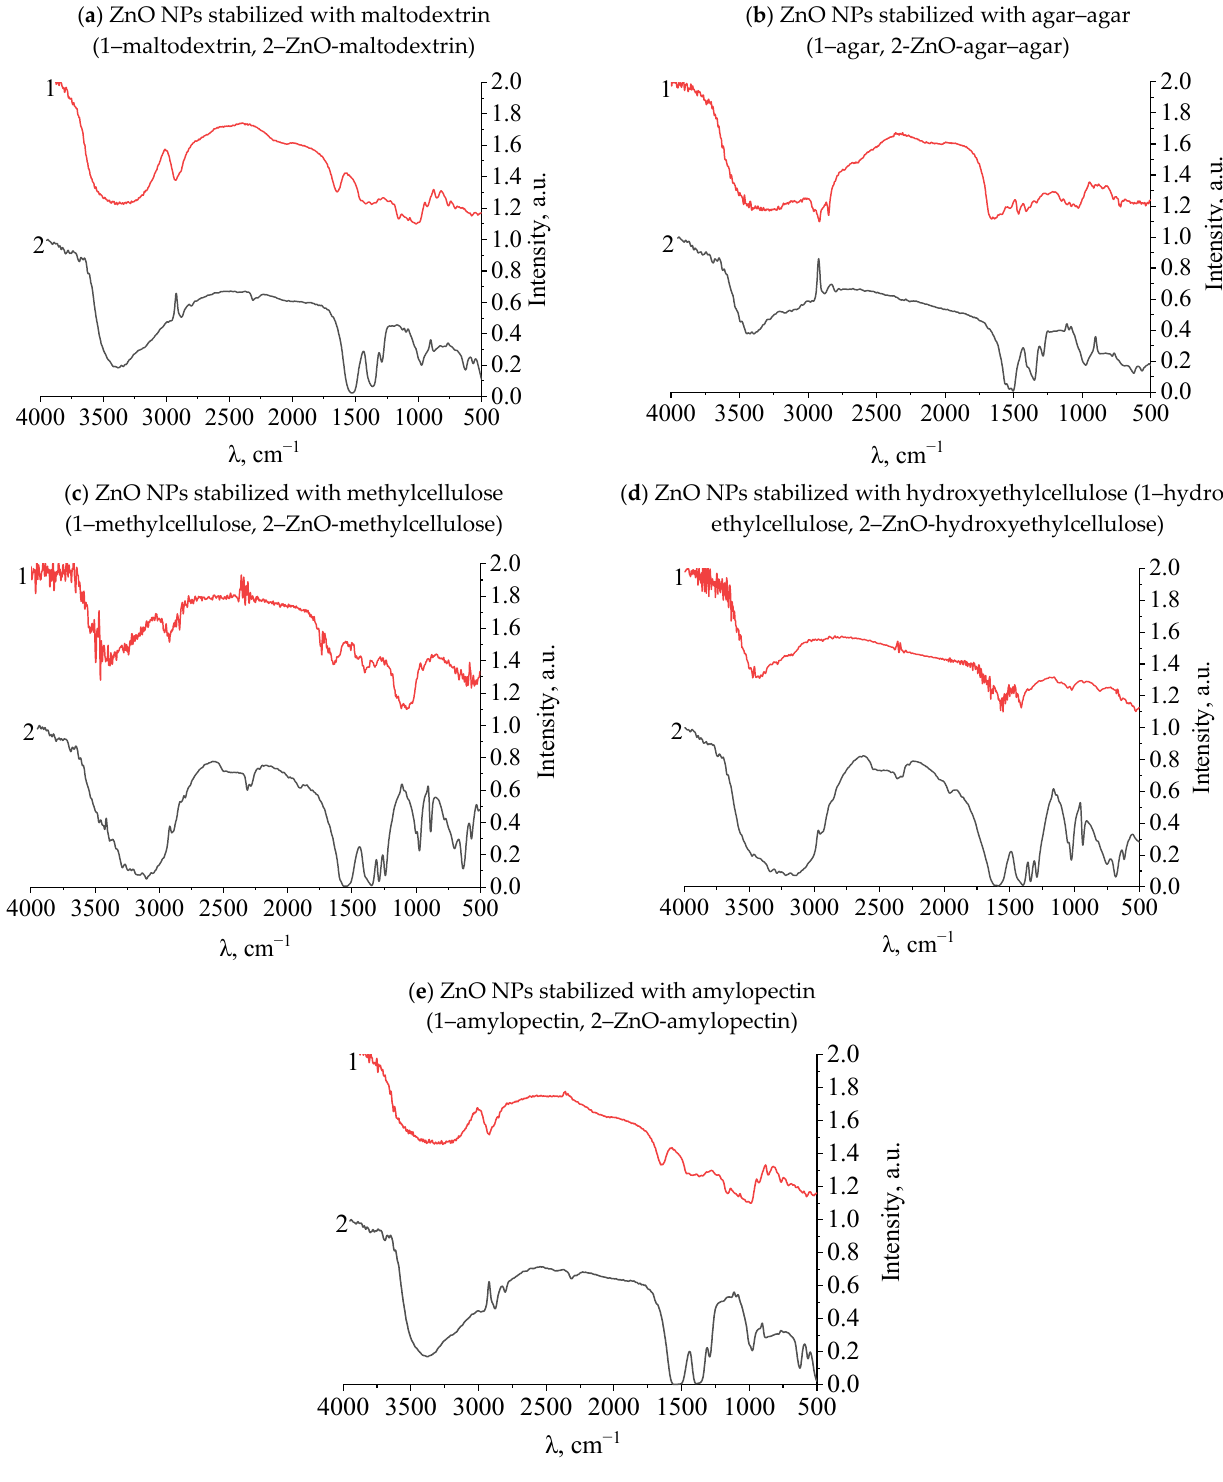
Figure 10. IR spectra of stabilized ZnO NPs.